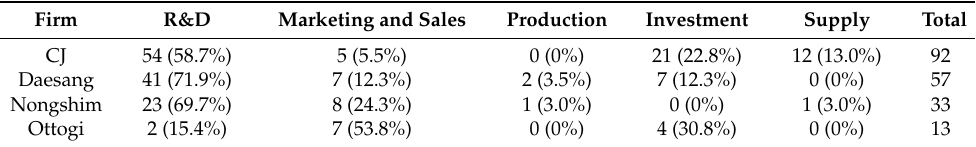
Table 3. Characteristics of alliances according to open innovation purpose